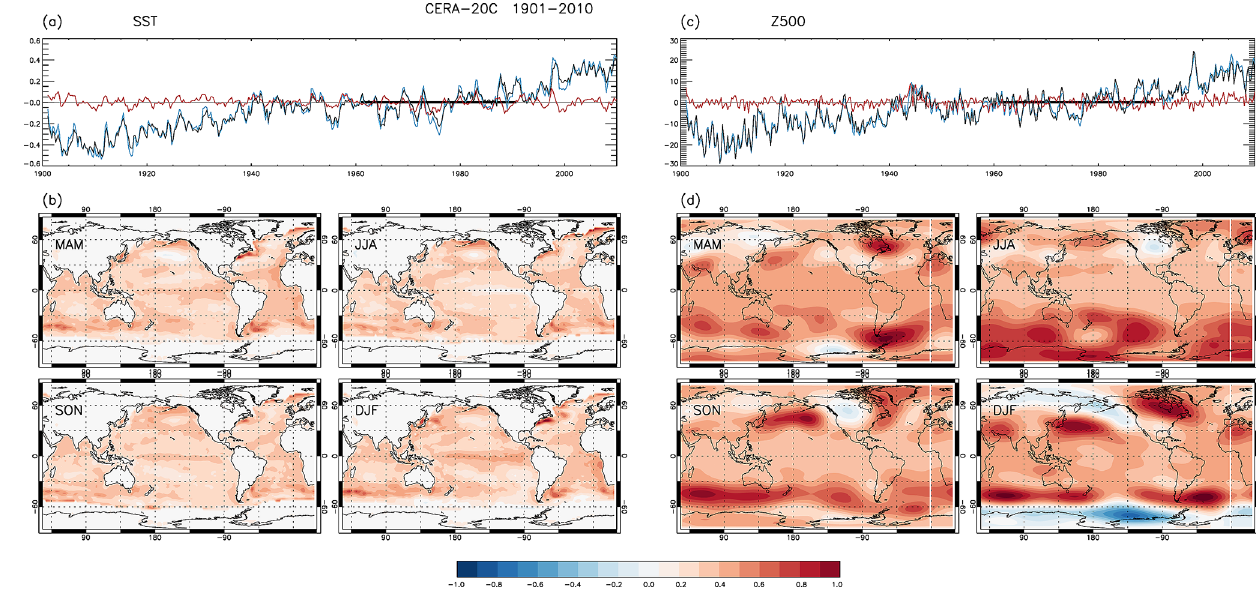
Figure 1. Season-reliant trend EOF of the CERA-20C SST and Z500 fields over the time period 1901–2010. Global mean SST (a) and global mean Z500 (c) anomaly with respect to base period 1961–1990 (blue), forced component thereof (black), and residual (red). (b, d) Respective seasonal trend-loading patterns in physical space (arbitrary units normalised to [ − 1 , 1] over all seasons).